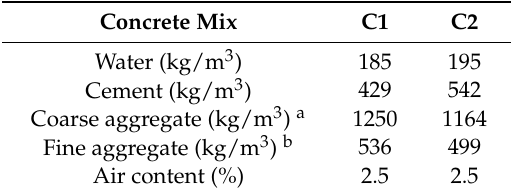
Table 2. Composition and characteristics of concrete.